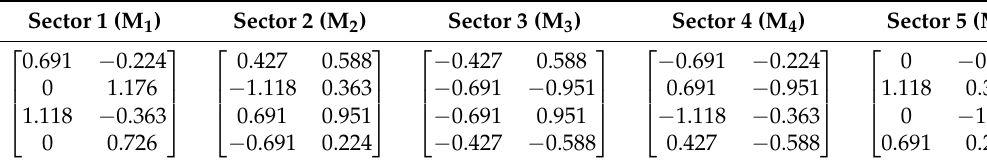
Table 3. Values of M s depending on the αβ plane sector.